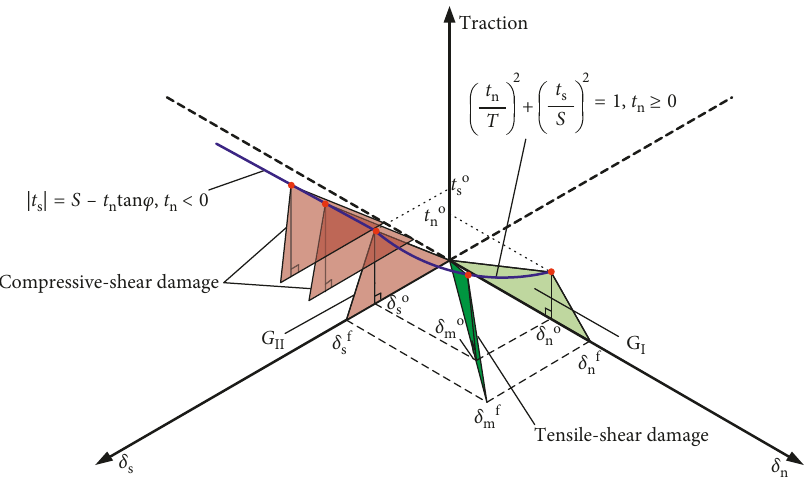
Figure 9: Illustration of the whole traction-separation law considering rock’s compressive shear strength characteristics. Table 1: Rock mechanical properties used in this study. Mechanical parameters Values Elastic modulus of the solid element, E o (GPa) 10.16 Poisson’s ratio of the solid element, v 0.28 Cohesion of the solid element, c (MPa) 18.3 Friction angle of the solid element, φ o ( ° ) 35.0 Tensile strength, s t (MPa) 3.97 Elastic modulus of the cohesive element, E n (GPa) 10.16 Shear modulus of the cohesive element, E s (GPa) 3.91 Pure shear strength of the cohesive element, S (MPa) 18.3 Tensile strength of the cohesive element, T (MPa) 3.97 Equivalent friction angle of the cohesive element, φ ( ° ) 35.0 103 154